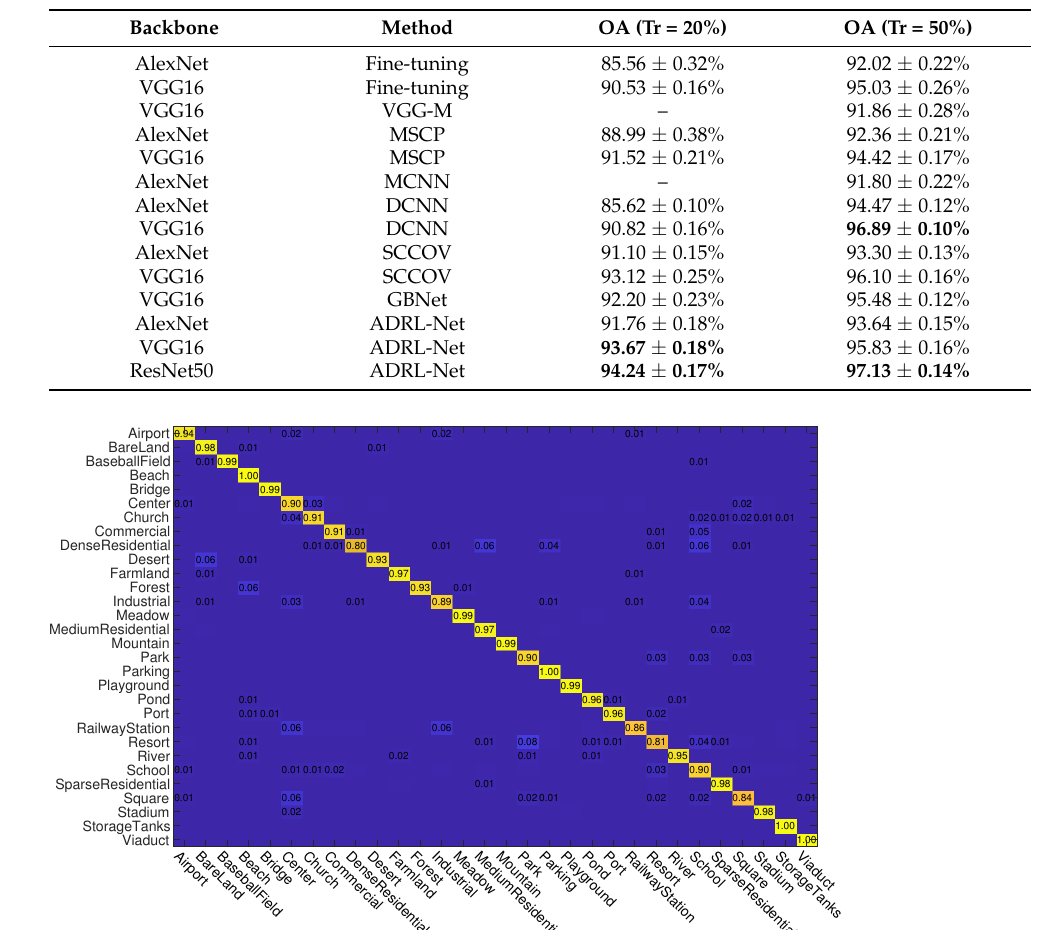
Table 1. OA comparison of different methods on AID dataset. The best two results are highlighted in bold font.